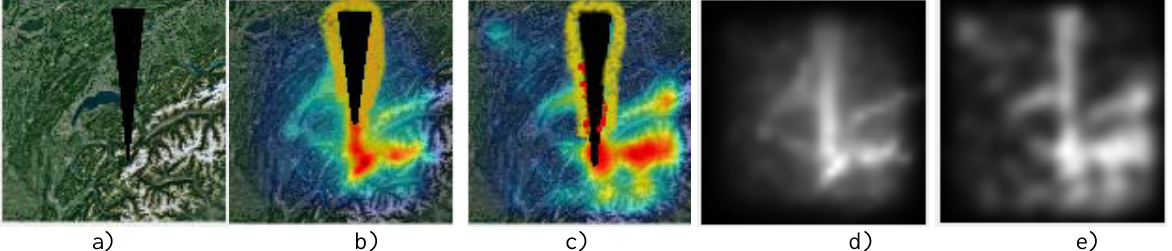
Fig.1. Saliency map for the underlying surface: a) image, with lost area, b) GVBS map overlayed, c) Itti/Koch map overlayed, d) GVBS map, d) Itti/Koch